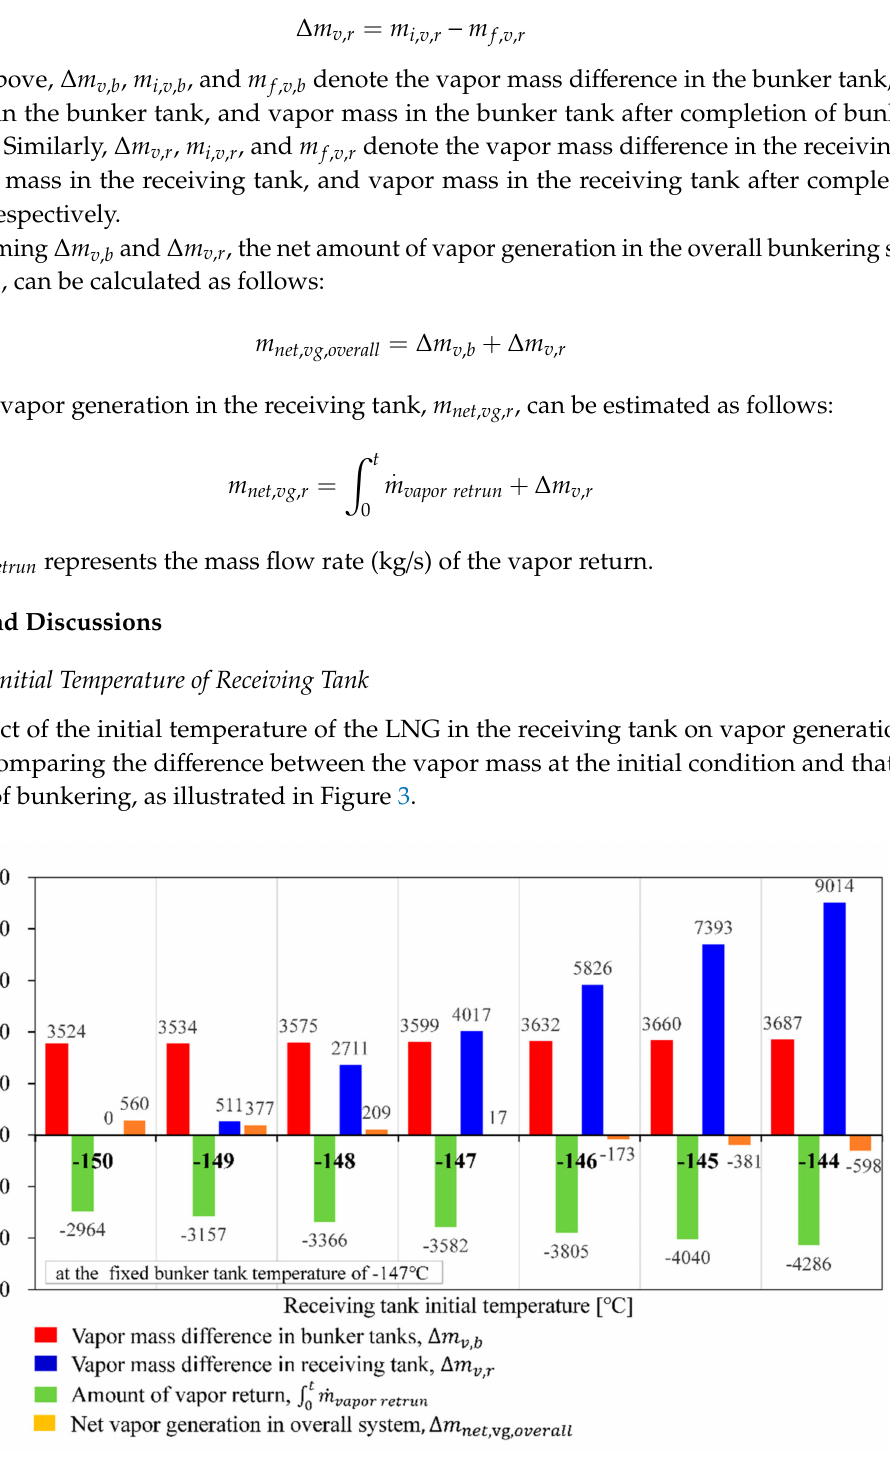
Figure 3. Comparison of vapor mass di ff erences with varying receiving tank initial